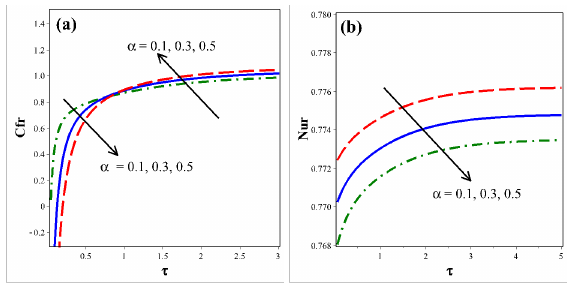
Fig. 3: Effect of second grade parameter on skin friction coefficient and Nusselt